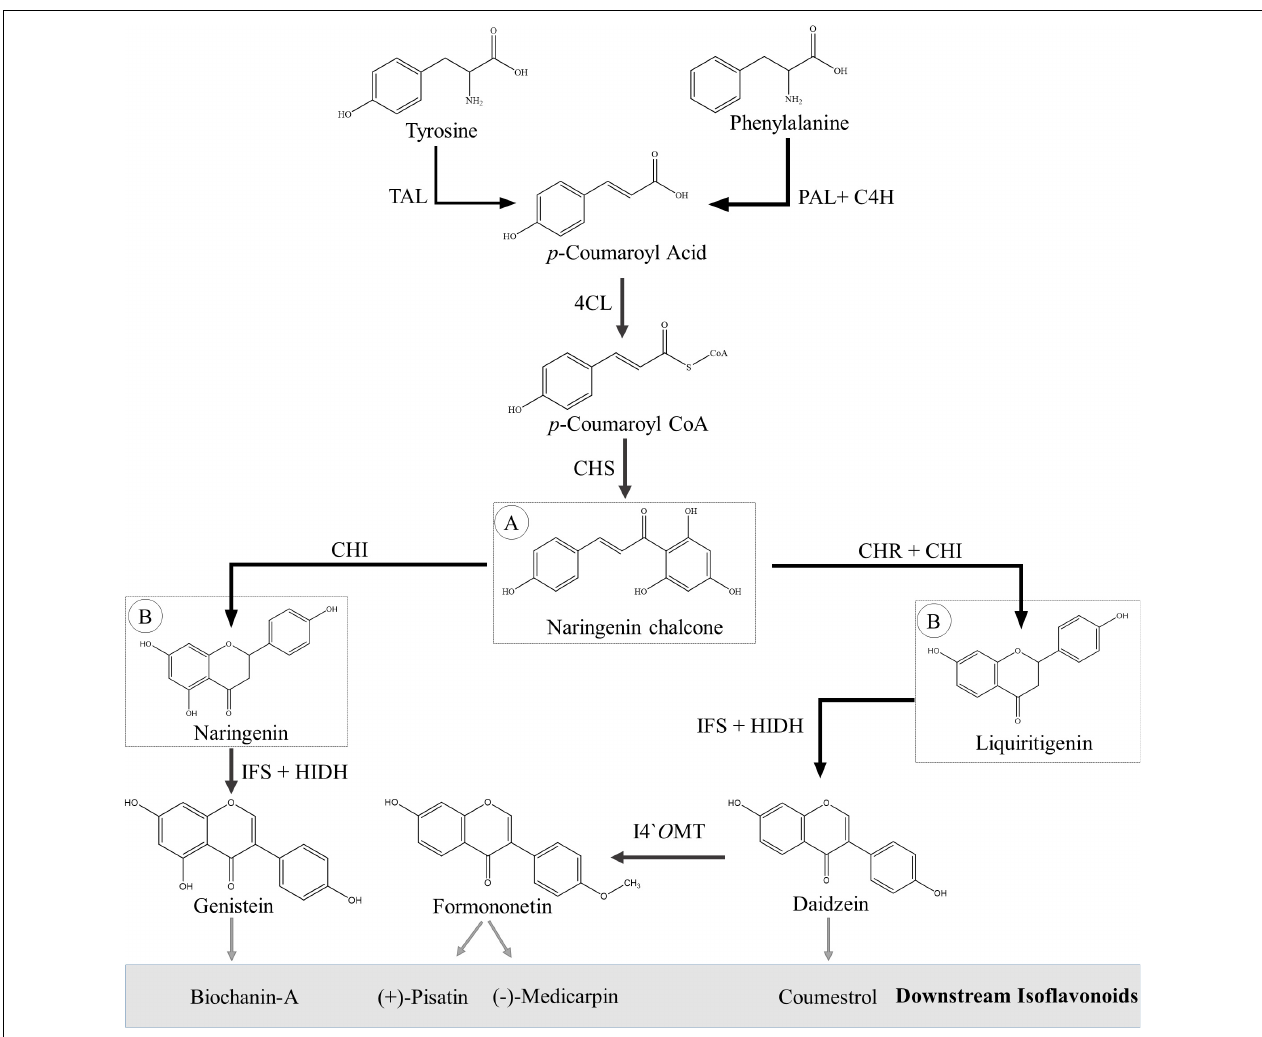
FIGURE 4 | Biosynthesis of basic isoflavonoids from amino acids (phenylalanine and tyrosine). (A) Flavonoid precursor molecule. (B) Isoflavonoid precursor molecules. Abbreviations, 4CL, 4-coumarate CoA ligase; C4H, trans -cinnamate 4-hydroxylase; CHI, chalcone isomerase; CHR, chalcone reductase; CHS, chalcone synthase; HIDH, 2-hydroxyisoflavanone dehydratase; I4 (cid:48) OMT, isoflavone 4 (cid:48) - O -methyltransferase; IFS, isoflavone synthase; PAL, phenylalanine ammonia lyase; TAL, tyrosine ammonia